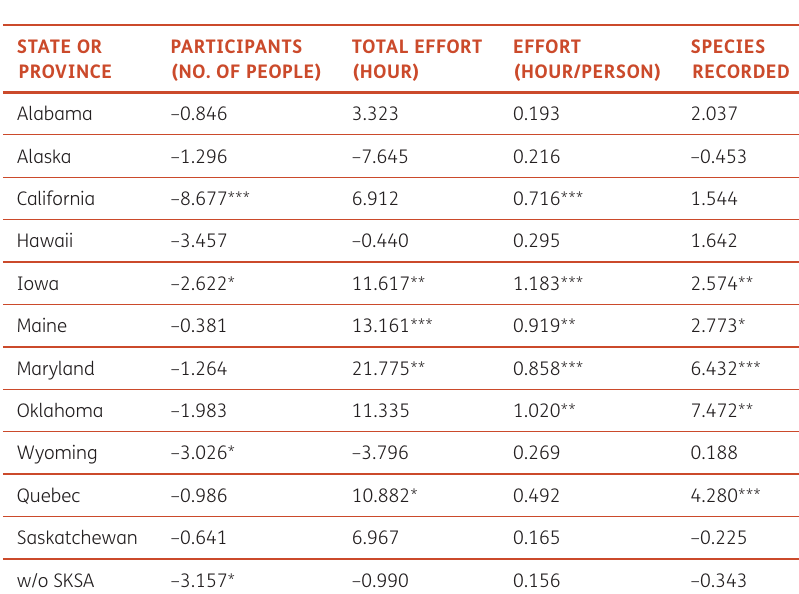
Figure 2 Spatial distribution of Christmas Bird Counts in California (a) and Saskatchewan (b) prior to the pandemic (2019) and during the pandemic (2020). Each circle represents one